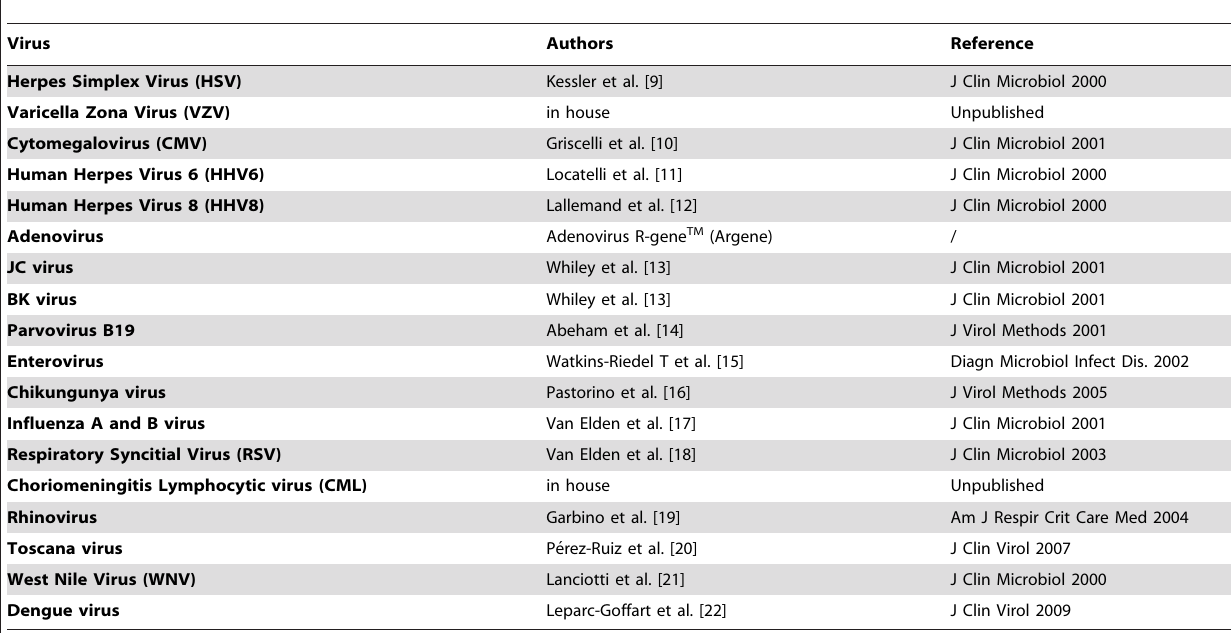
Table 1. PCR systems used for the detection of DNA or RNA viruses.